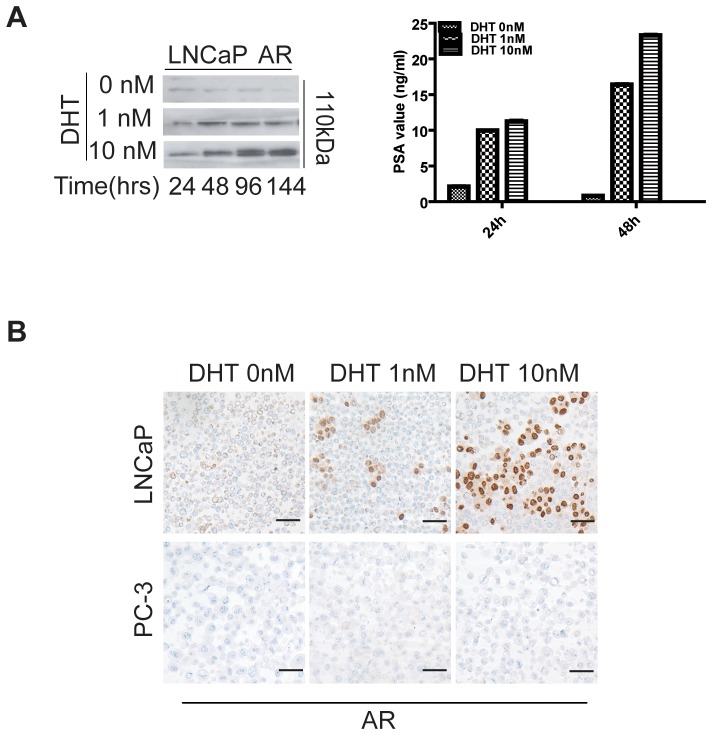
DHT upregulates AR expression and increases PSA secretion in LNCaP cells.(A) DHT upregulates AR expression in LNCaP cells in both time-dependent and concentration-dependent manners (left panel); there are also higher levels of PSA in the DHT treated cells revealed by the ELISA method (right panel). (B) Immunocytochemistry shows nuclear positivity of AR in LNCaP cells and its expression is upregulated by DHT treatment; but AR expression is negative in the PC-3 cells with/without DHT treatment (bar scale: 50 µm).